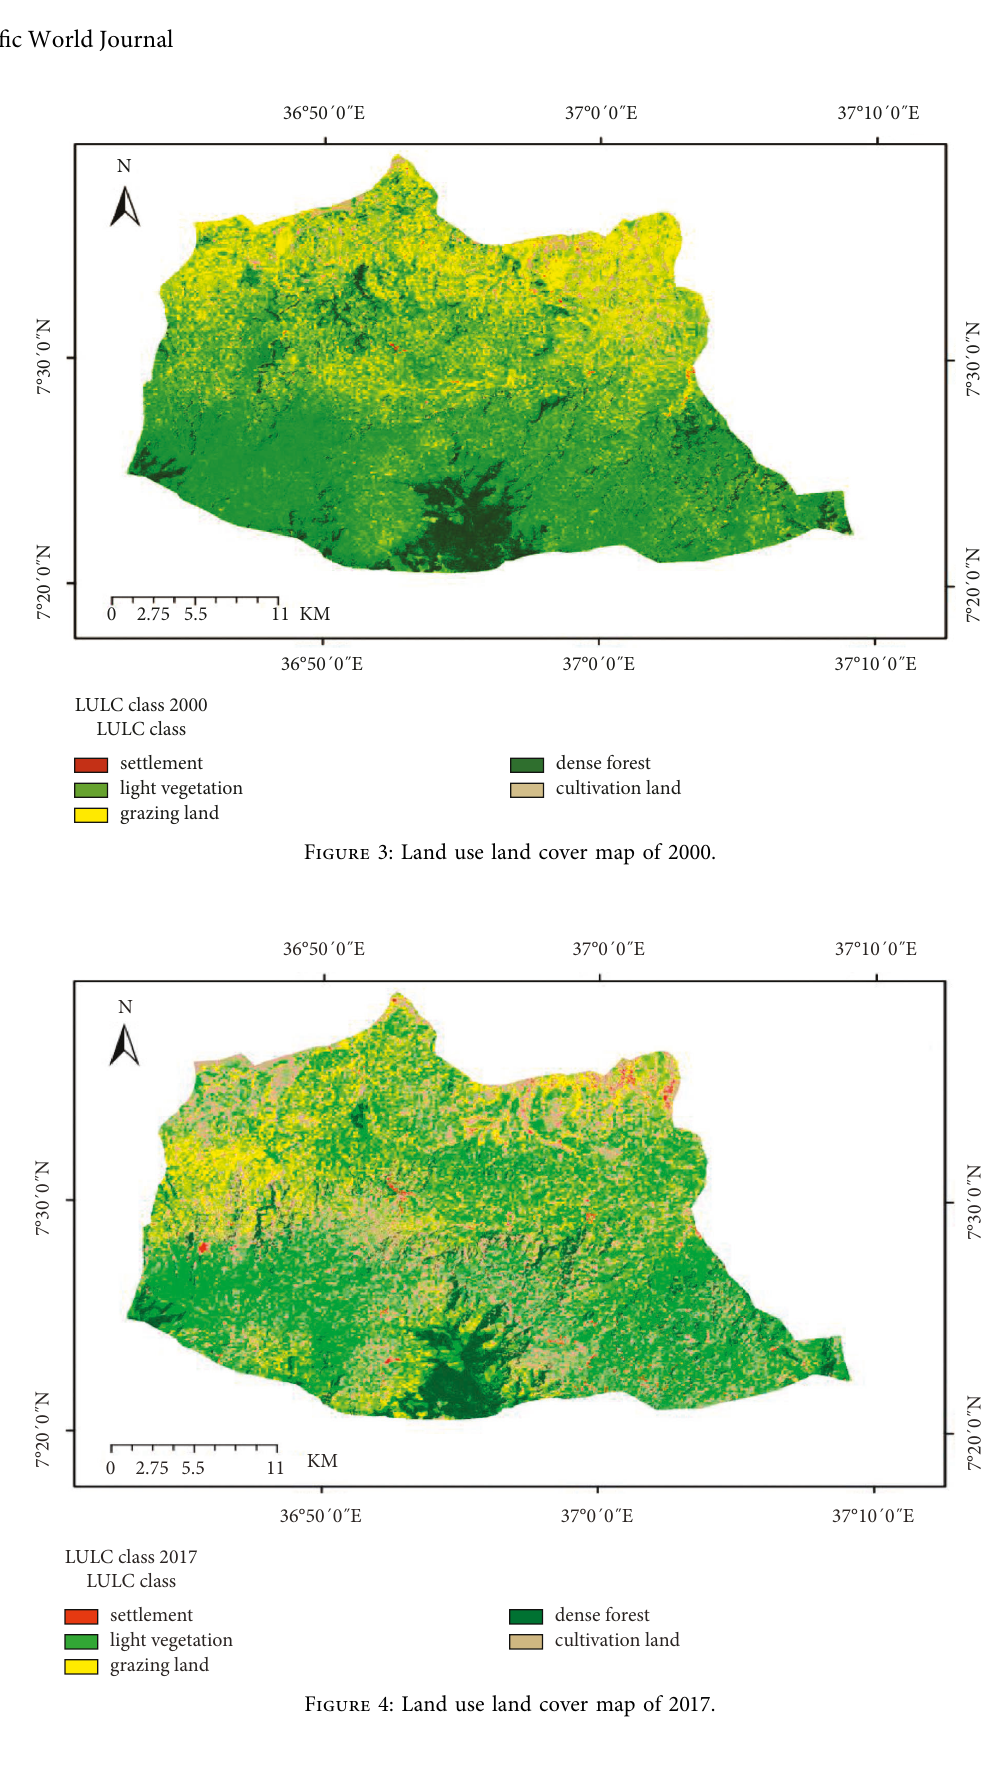
Figure 4: Land use land cover map of